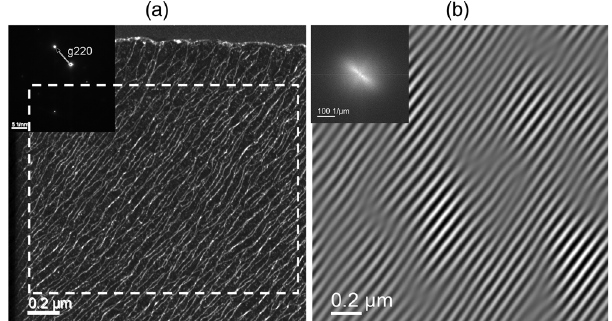
FIG. 2. (a) A dark-field TEM image of a soft OFHC Cu sample ( ∼ 100 nm thick lamella) under two-beam g:220 diffraction conditions, displaying a typical ladder-like dislocation structure, with the corresponding diffraction pattern (upper left corner). (b) Fourier filtered region enclosed by the dashed rectangle in (a), spatial frequencies farther away than ∼ 10 μ m − 1 from the peak spatial frequency filtered out. The FFT of the region is shown in the upper left corner. The peak spatial frequency corresponds to a transverse distance of 62 nm between dislocation